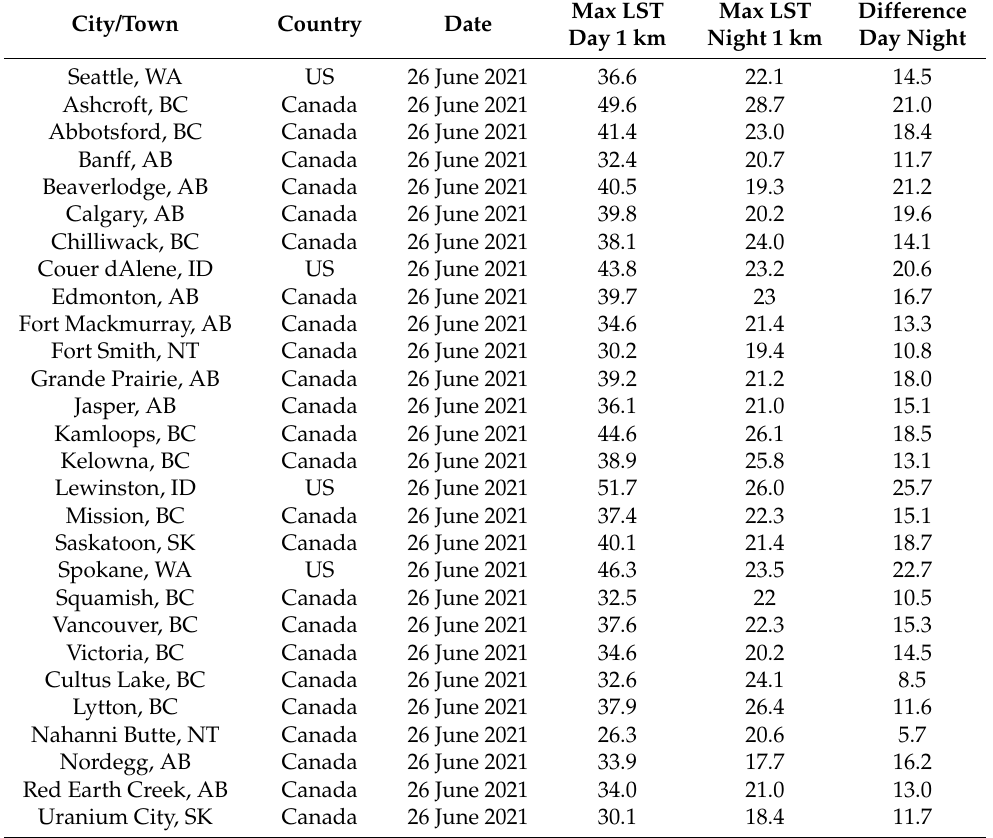
Table 2. Maximum MODIS LST values for the 2000–2021 period over the subset of 28 cities. LST is given in ◦ C. In all cases, the date when the maximum LST value was reached is 26 June